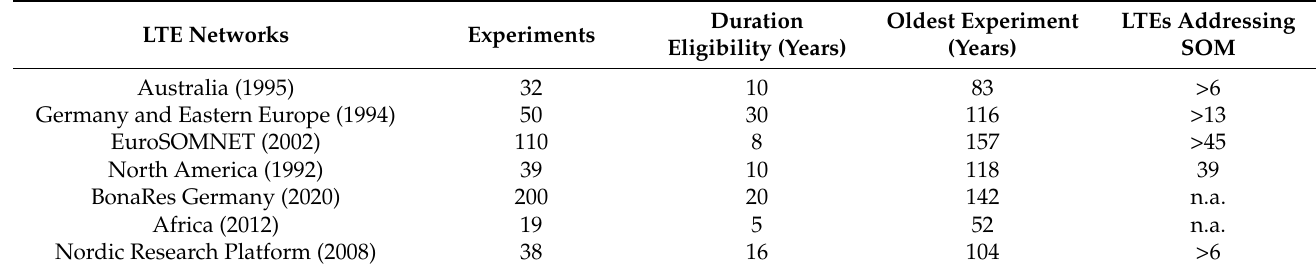
Table 2. Main features of the LTE networks addressing SOM studies (at the time that the information was